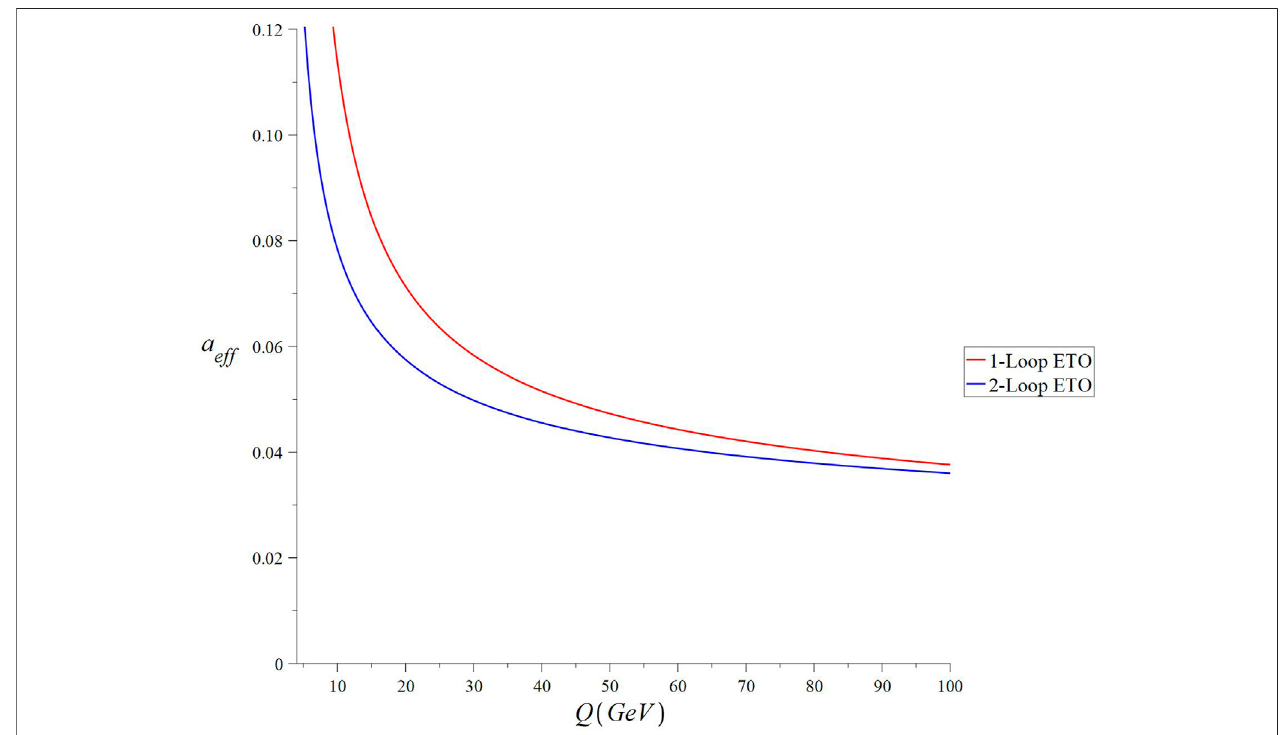
FIGURE 3 | Q dependence of RSS-independent coupling a eff at one- and two-loop orders.